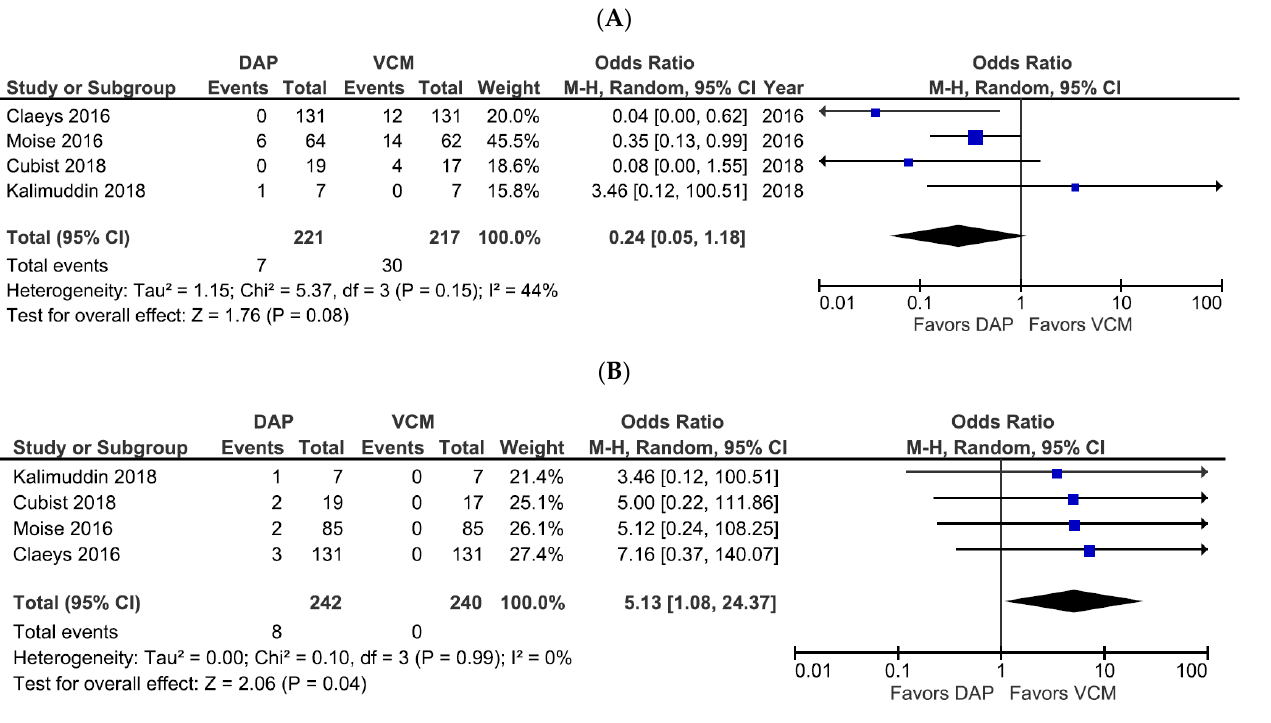
Figure 5. Forest plots of the safety of DAP versus VCM for the treatment of patients with bacteremia caused by MRSA with VCM MIC > 1 µg/mL. ( A , B ) Forest plots of the incidence of nephrotoxicity ( A ) and CPK elevation ( B ) in patients treated with DAP versus VCM in the studies evaluated. Symbols and abbreviations are as described in Figure 2.